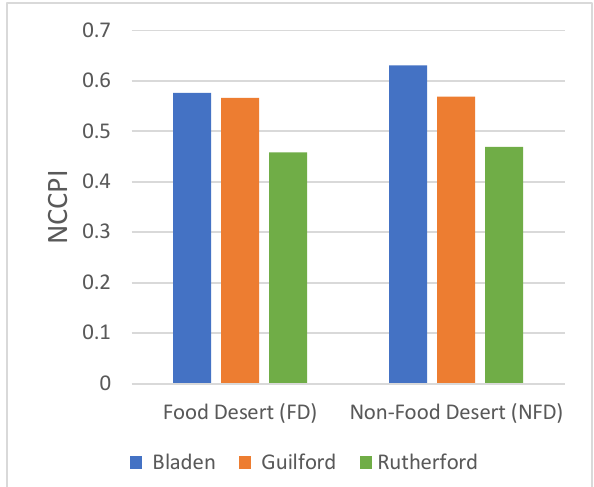
Figure 8. Average productivity of farmland